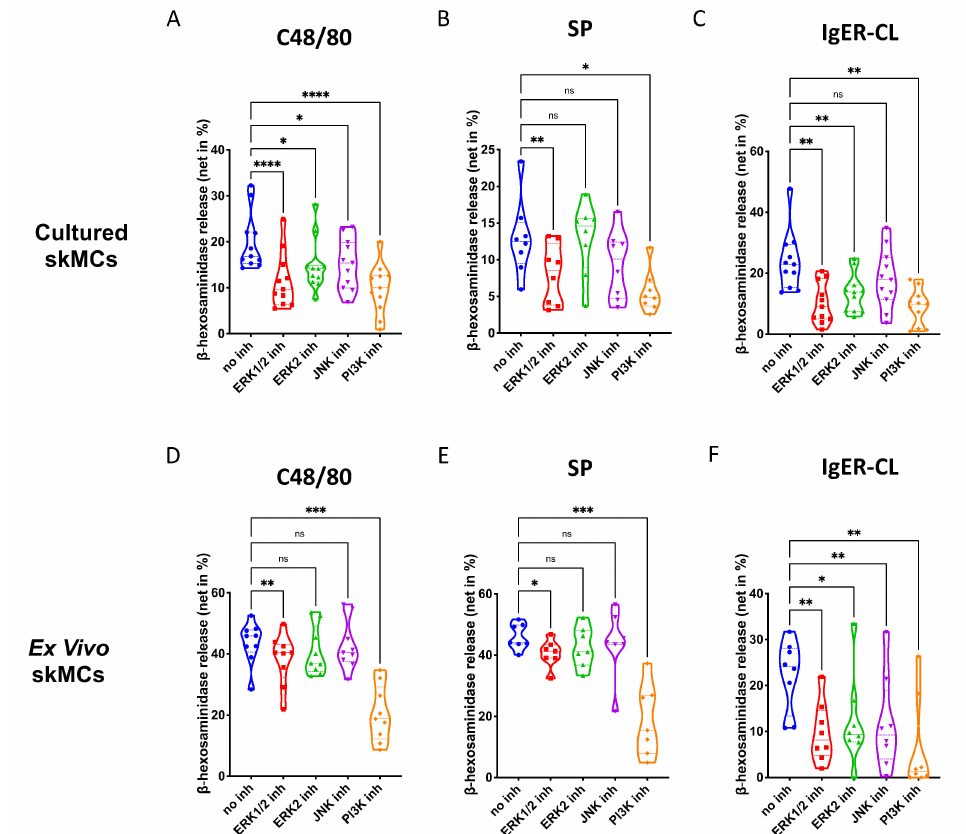
Figure 2. Both ERK and PI3K contribute to the degranulation of skin MCs stimulated by MRGPRX2 or Fc ε RI. ( A – C ) Cultured and ( D – F ) ex vivo skin MCs were pretreated with inhibitors targeting ERK1 and ERK2 indiscriminately (SCH772984, 10 µ M), ERK2 only (Vx-11e, 2 µ M), JNK (SP600125, 5 µ M), or PI3K (Pictilisib, 5 µ M). β -hexosaminidase release stimulated by c48/80 (10 µ g/mL), SP (30 µ M) or IgER-cross-linking (CL) (by AER-37 antibody for cultured MCs at 0.1 µ g/mL; by anti-Fc ε RI α -Ab 29C6 for ex vivo MCs at 0.5 µ g/mL) was determined. The data are from 7–11 independent experiments, ns: not significant, * p < 0.05, ** p < 0.01, *** p < 0.001, **** p < 0.0001. skMCs: skin mast